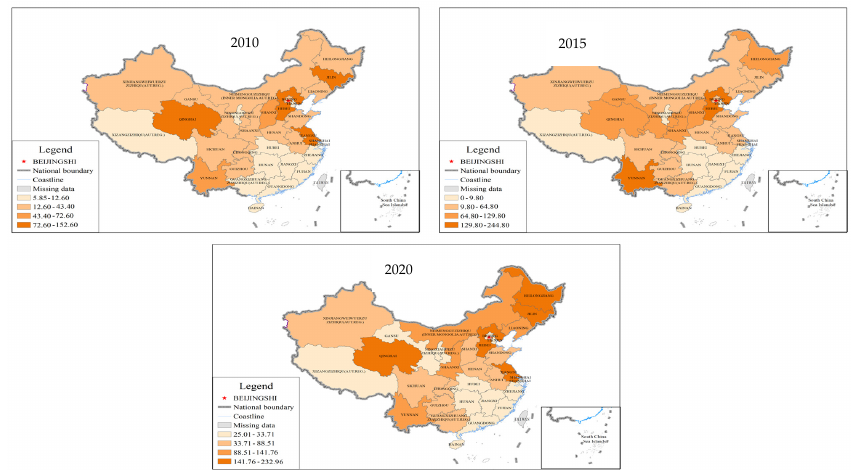
Figure 1. The evolution of R&D expenditure on FLB in 2010, 2015 and 2020 .